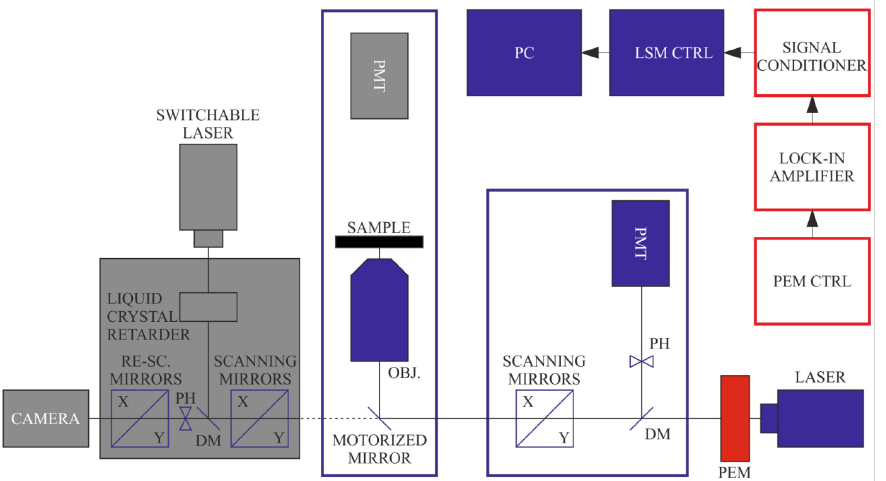
Figure 7. For cell wall structure investigations, we have applied the confocal FDLD imaging with polarization-modulated excitation and using fluorescence detection. (Components inactive in this configuration are displayed in